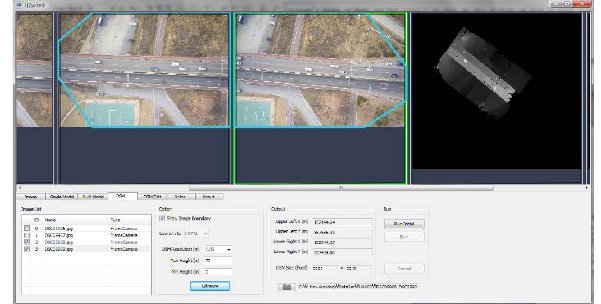
Figure 5. Layout of SW tool used for experiments